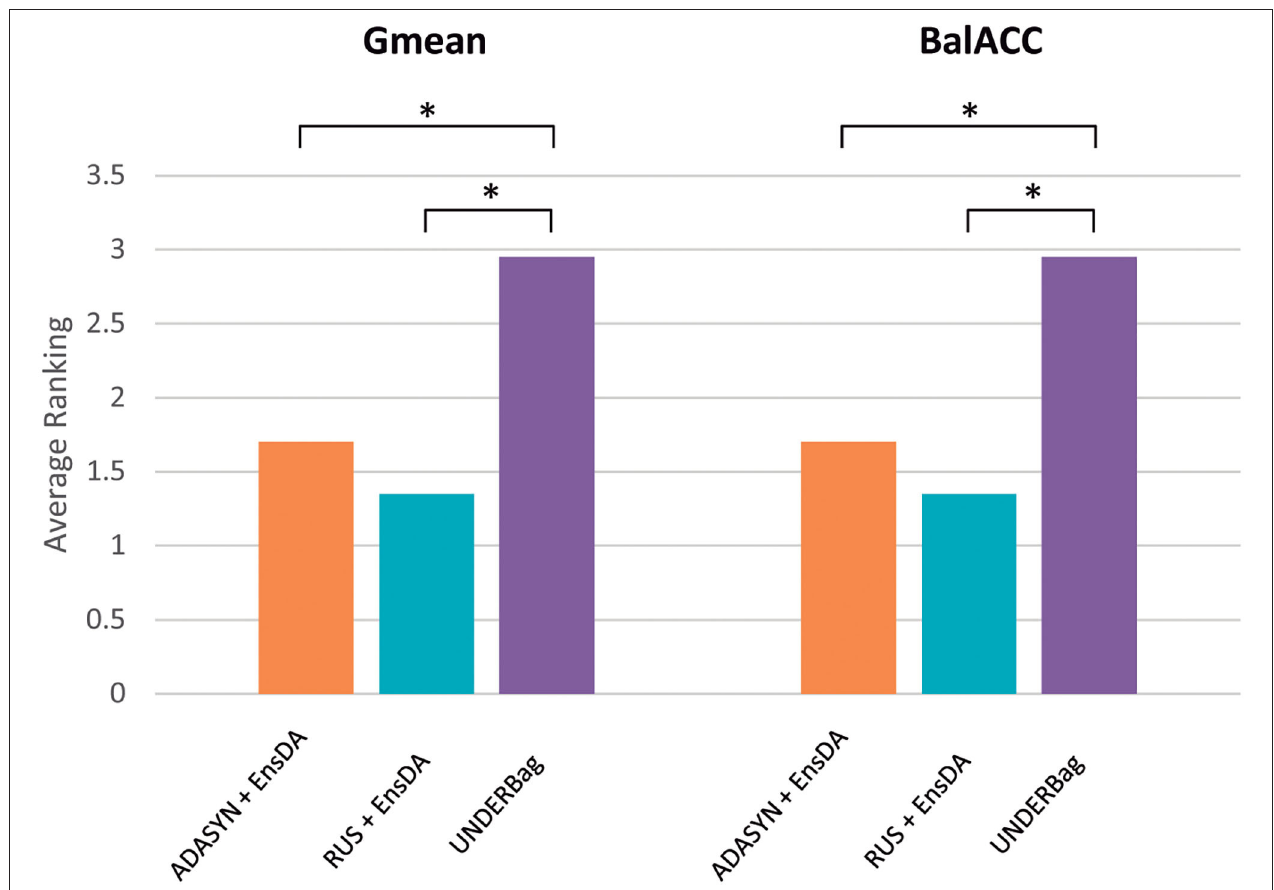
FIGURE 5 | A final comparison of performances among the best approach for each of the resampling families considered: (1) Oversampling: ADASYN [Adaptive Synthetic Sampling (ADASYN) combined with “classical” ensemble approach EnsembleDA; orange bars]; (2) Undersampling: RUS Undersampling (RUS) combined with “classical” ensemble approach EnsembleDA —blue bars]; (3) Specific ensemble learner for imbalanced domain: UNDERBagging (violet bars). Y -axis represents ranking values, for both the Gmean and BalACC. The lower-ranking values indicate better performances. *indicates significant differences according to Shaffer’s post-hoc